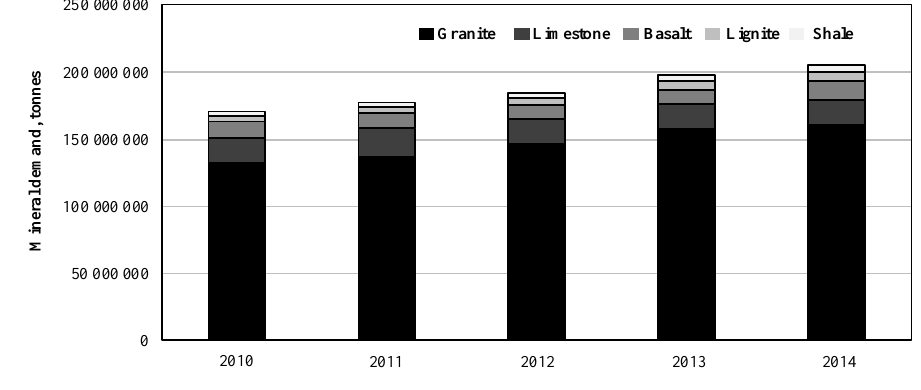
Fig. 2. Mineral resources demand in Thailand, 2010–2014